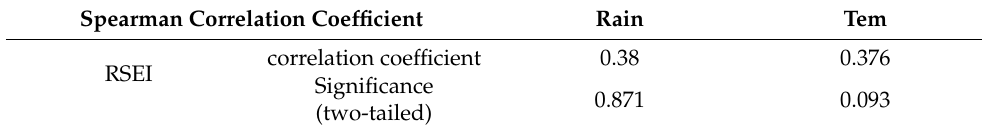
Table 4. Chart of correlation statistics of temperature, rainfall and